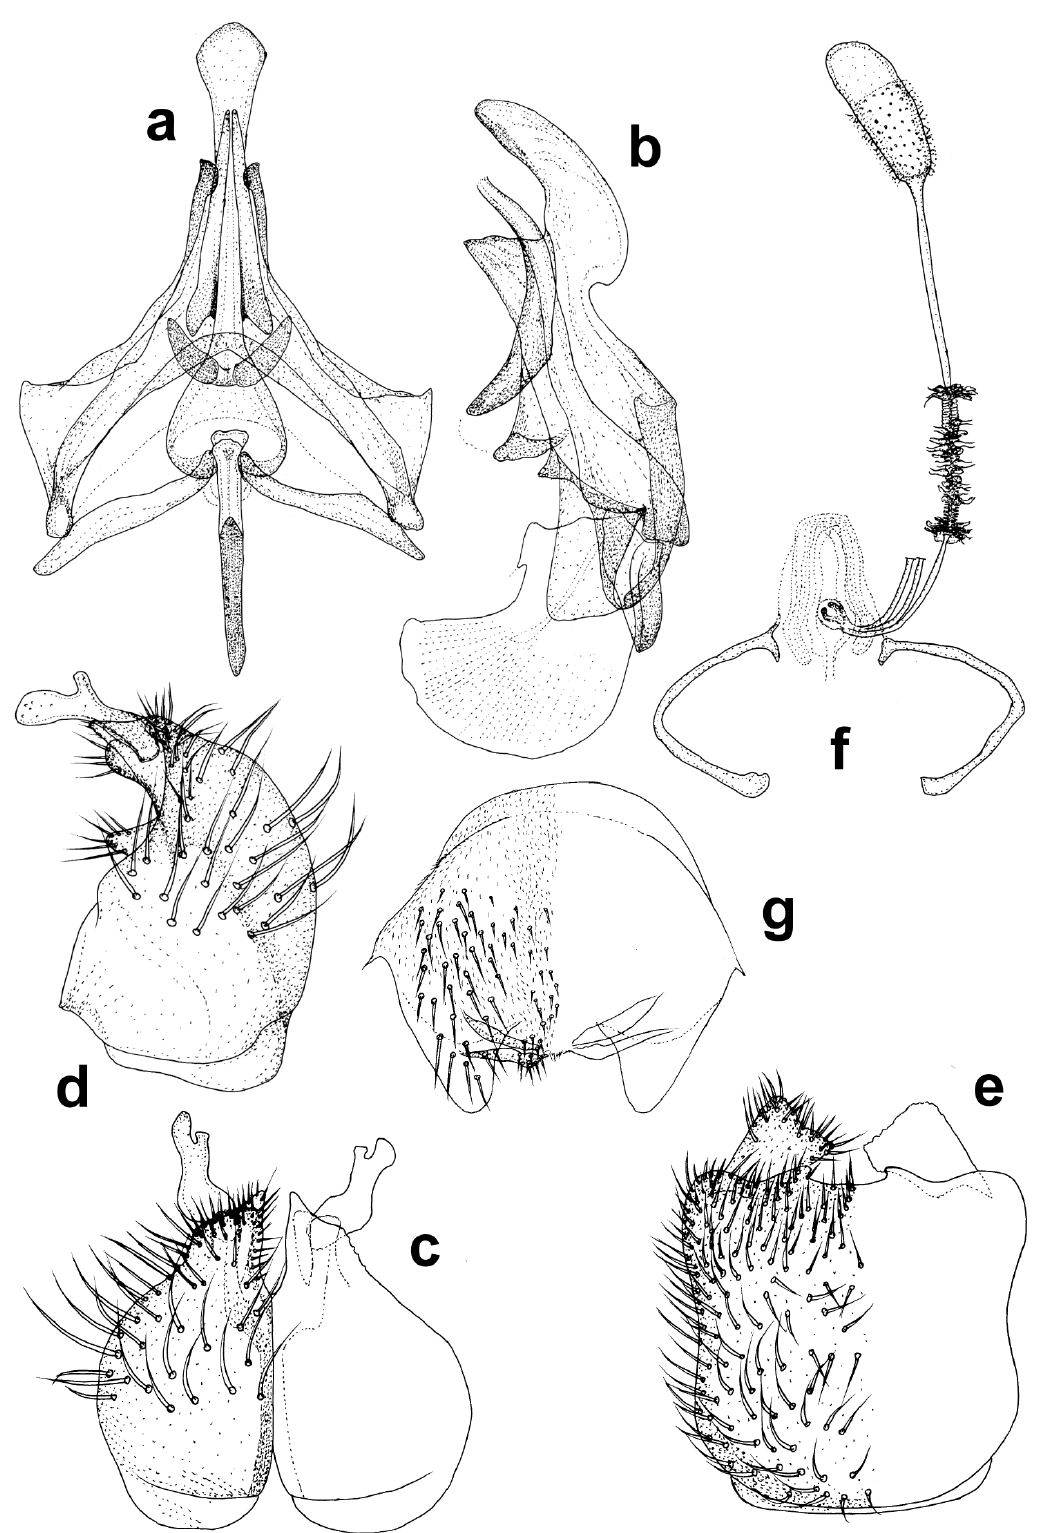
Fig. 35. Parageron lutescens (Bezzi, 1925), typical form. a . Epiphallic complex ventral. b . Epiphallic complex lateral. c . Gonocoxite ventral. d . Gonocoxite lateral. e . Epandrium dorsal. f . Female genitalia ventral. g . Female sternite 8